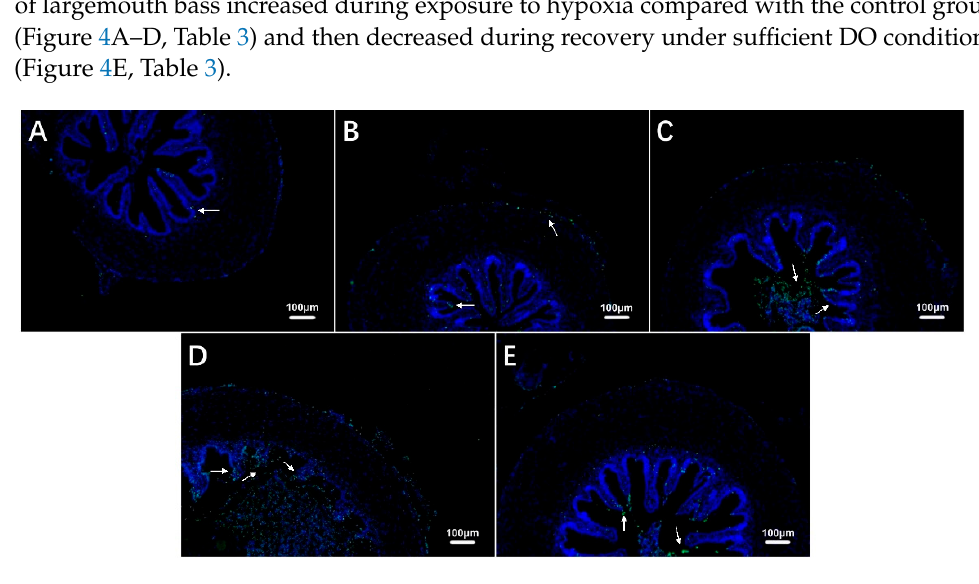
Figure 4. Effects of hypoxic stress (0 h ( A ), 6 h ( B ), 24 h ( C ), 96 h ( D )) and reoxygenation (96 h ( E )) on intestinal cell apoptosis in largemouth bass ( n = 12). White arrows indicate apoptotic cells.